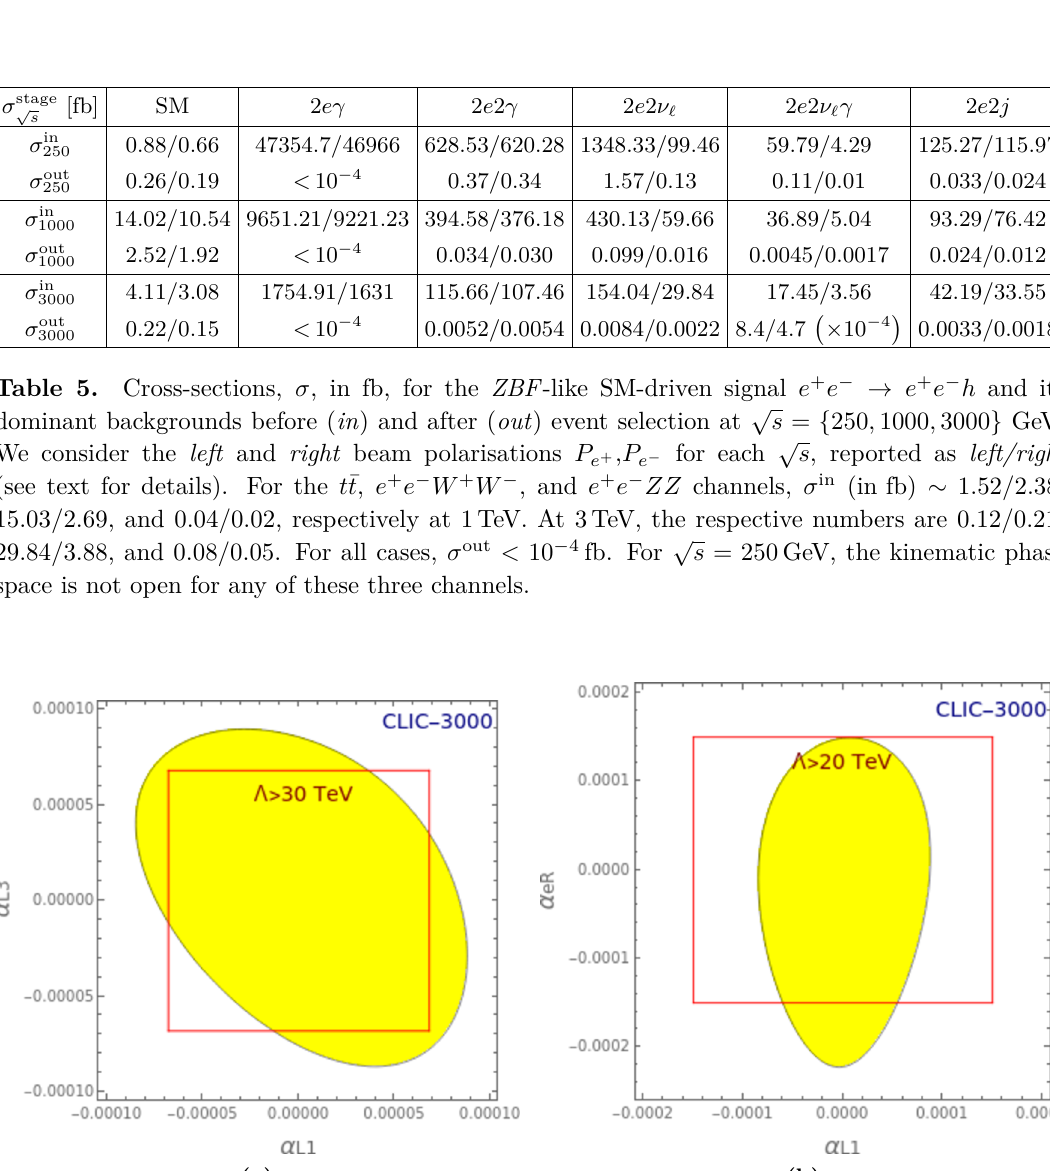
= − c e v 2 / Λ 2 , α L 1 = R R